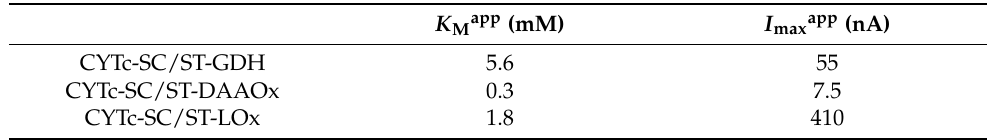
Table 3. Apparent K M value ( K Mapp ) and apparent I maxapp value calculated from DET current